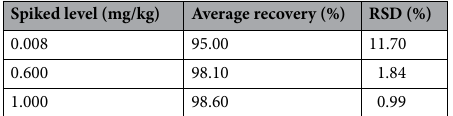
Spiked level (mg/kg)